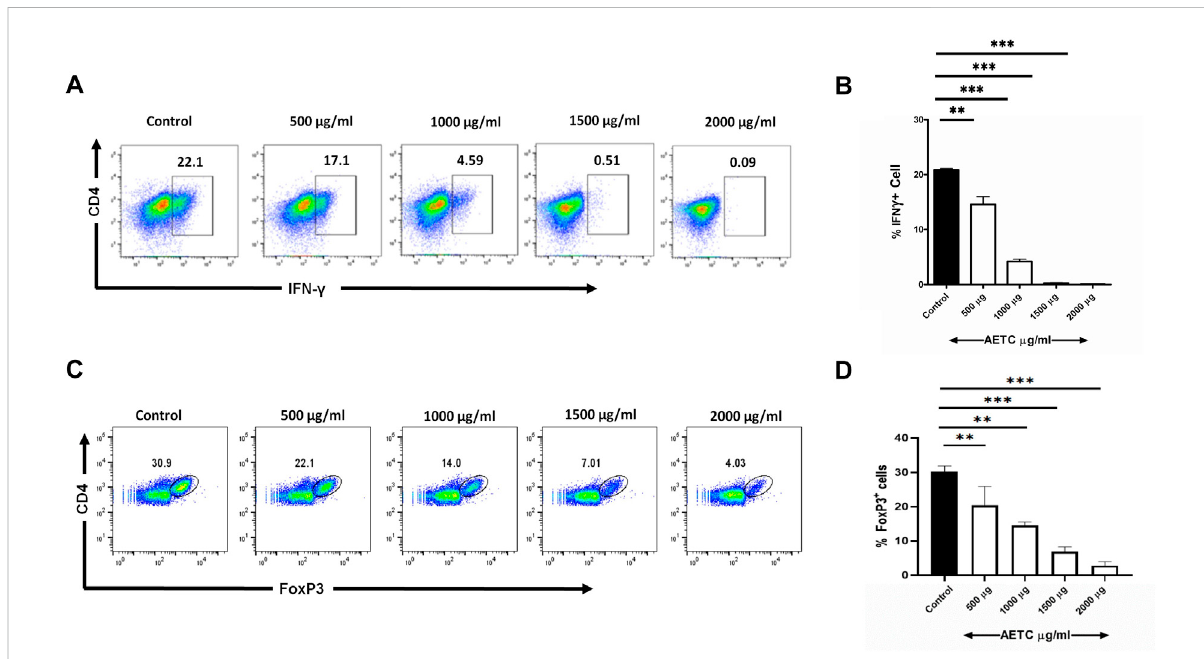
FIGURE 4 T. cordifolia extract downregulates IFN- γ production in Th1 cells and FoxP3 expression in iTreg cells. (A,B) Frequency of IFN- γ + cells following the culture of naive T cells for 5 days under Th1-polarizing conditions in the presence of AETC (500 – 2000 µg/ml) or vehicle control. Cells were stained for intracellular IFN- γ and were gated on live cells. (A) Representative fl ow cytometry. Numbers represent the percentage of IFN- γ + T cells among total live cells. (B) Percentage of IFN- γ + T cells among total live cells cultured with AETC (500 – 2000 µg/ml) or vehicle control. (C,D) Frequency ofFoxP3 + cells following theculture of naive Tcells for 4 days under iTreg polarizing conditions in thepresence of AETC (500 – 2000 µg/ ml) or vehicle control. Cells were stained for intracellular FoxP3 and were gated on live cells. (C) Representative fl ow cytometry. Numbers represent thepercentageofFoxP3 + Tcellsamongtotallivecells. (D) PercentageofFoxP3 + cellsamongtotallivecellsculturedwithAETC(500 – 2000 µg/ml)or vehicle control. Results are representative of three independent experiments. Error bars represent the mean ± SEM of triplicates. * p < .05, ** p